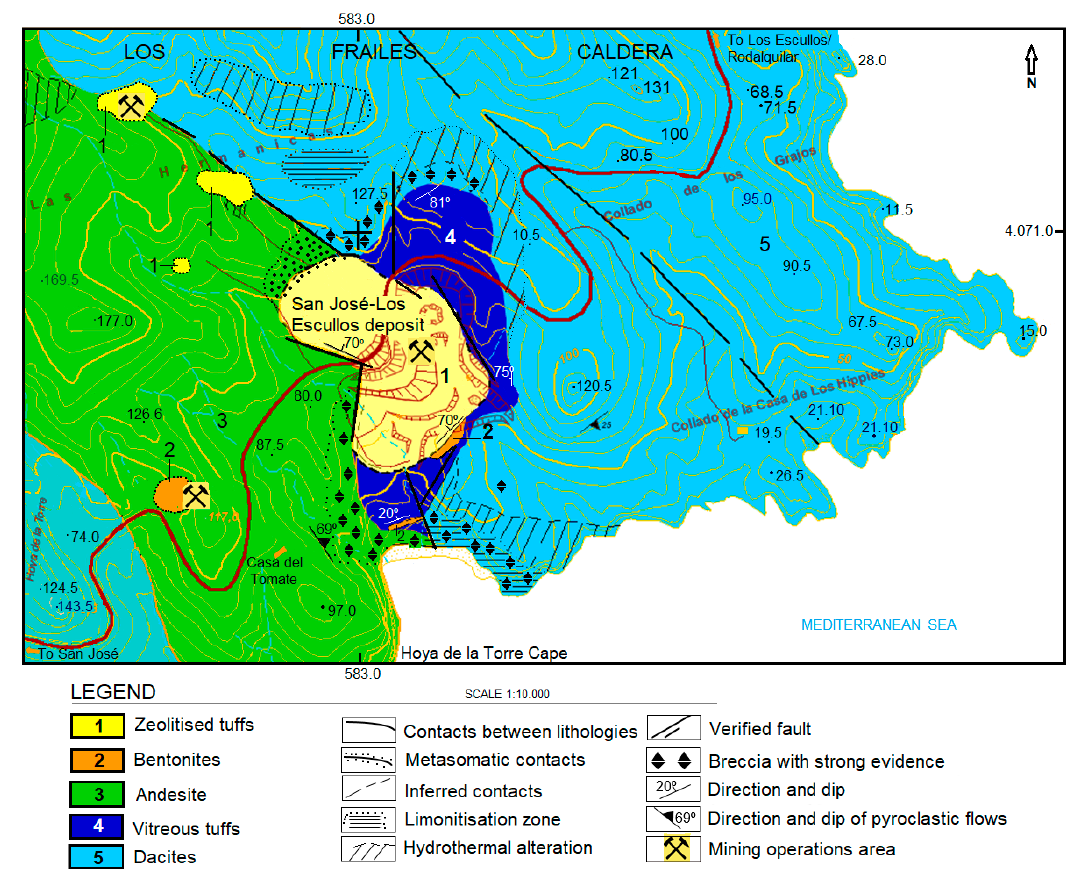
Figure 2. Geological map of the research area. Modified from Costafreda